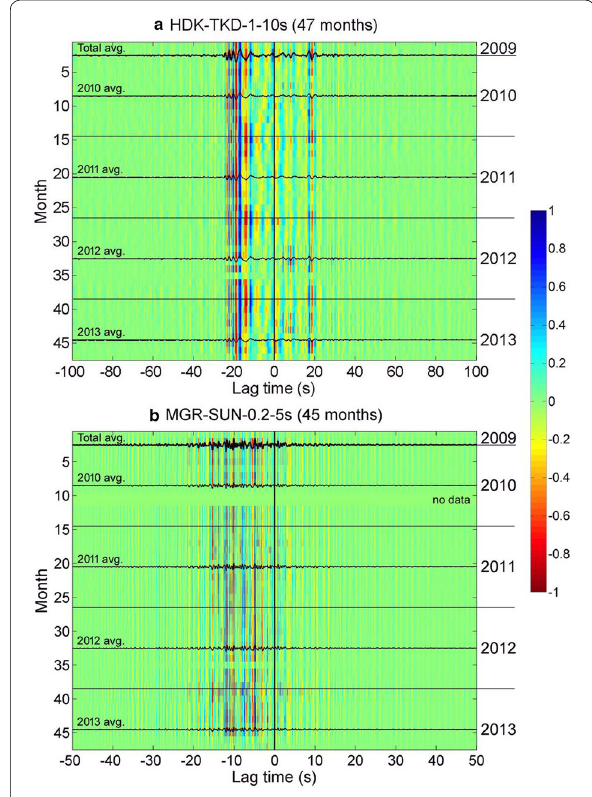
Fig. 3 Examples of monthly CCFs for a the BB station pair (HDK–TKD) with 100‑s lag time in the 1–10‑s period band and b the SP station pair (MGR–SUN) with 50‑s lag time in the 0.2–5‑s period band. Color heatmap correlates to the normalized amplitude of CCFs. Black lines indicate the total and annual average of the monthly CCFs. The data length (in months) is displayed in